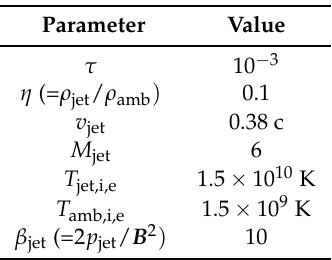
Table 1. List of jet parameters.